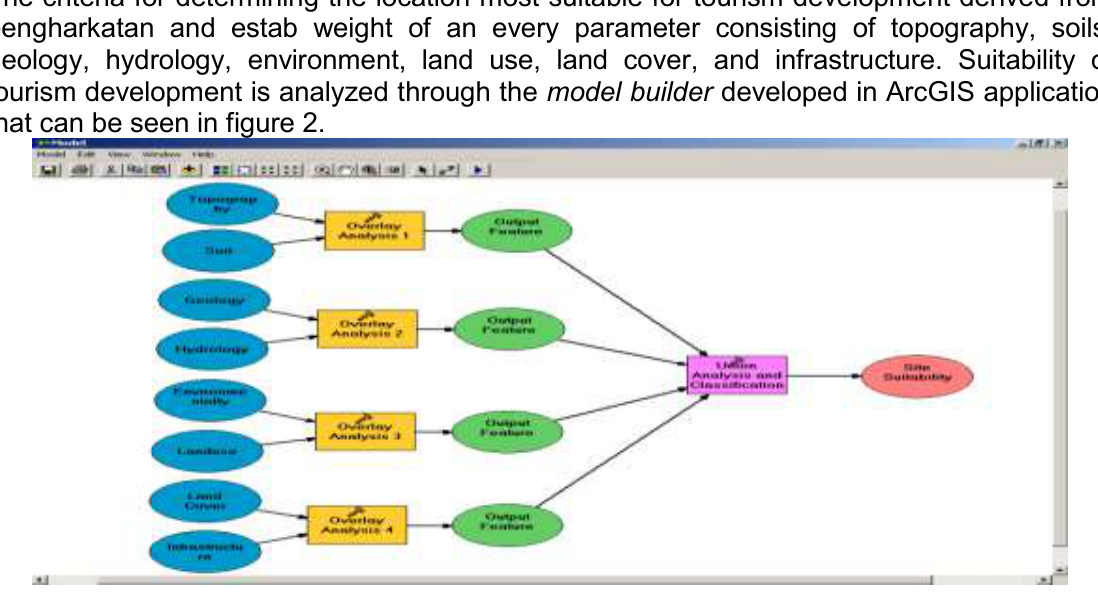
Figure 2. Model Builder Conformity Tourism Development Area (Source: Pareta,